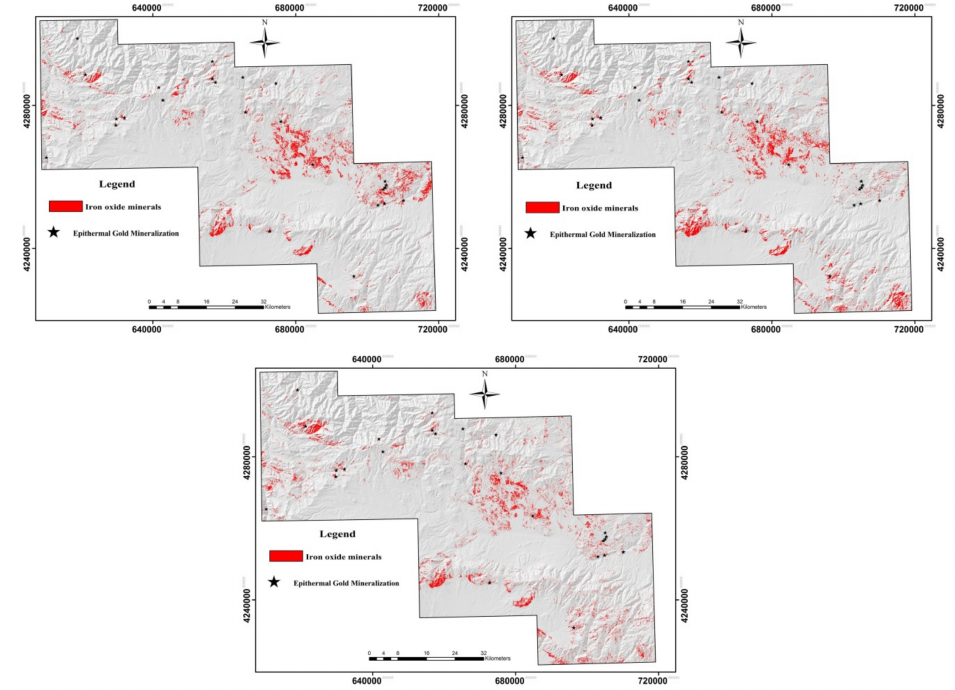
Figure 5. Spatial distribution of iron oxide / hydroxide zones (gossan) in the study area overlaid on hill shade. ( A ) The 3 / 1 band ratio image of Landsat-7 ETM + ; ( B ) the 4 / 2 band ratio image of Landsat-8; ( C ) the 2 / 1 band ratio image of ASTER.